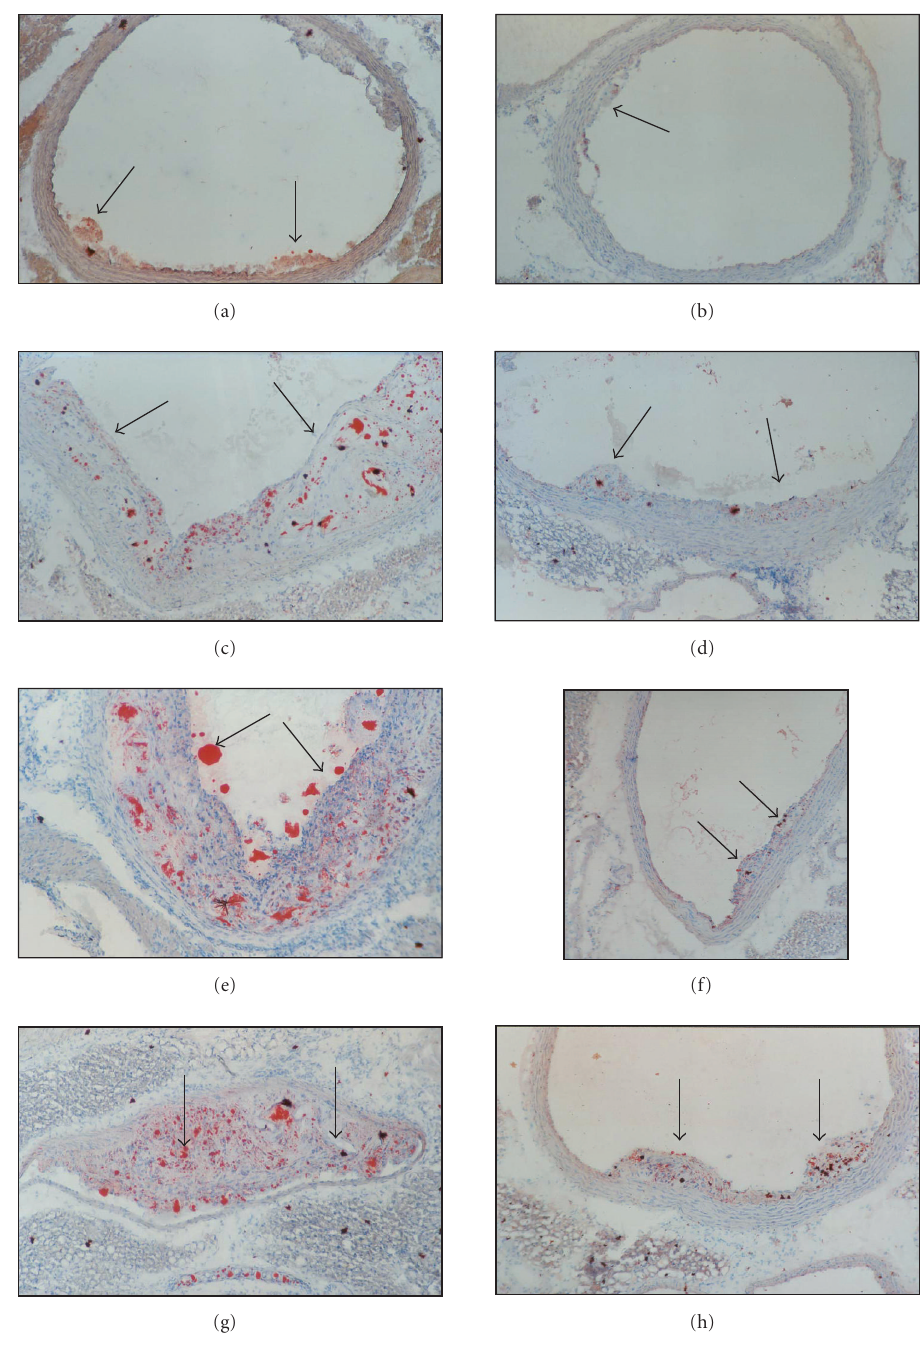
Figure 2: Oil red O staining of ApoE − / − (SKO) and ApoE − / − , P -selectin − / − (DKO) mice . The size of ORO-stained aortic lesions is observed to be larger in SKO compared to DKO mice fed a 6- (a-b), 15- (c-d), and 20- (e-h) week fat diet. Lipid ORO-stained droplets are present in aortic lesions from SKO and DKO lesions. At 20 weeks, total lumen obstruction of aortic arch is observed in an ApoE − / − animal (g). Black arrows show atherosclerotic lesions. Original magnification: x100 (a, b, f, g, h) and x250 (c, d, e).